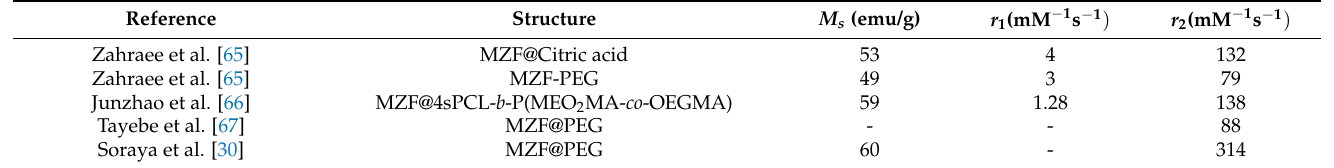
Table 3. Some magnetic and relaxivity properties of MZF with different coatings.